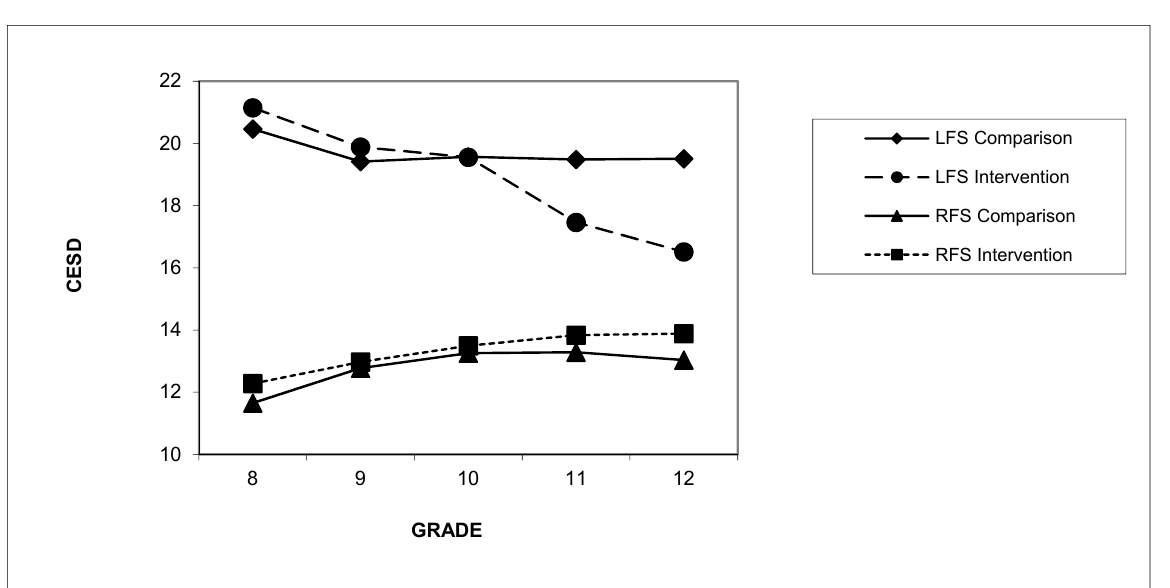
Figure 2. Estimated means for depression scores from Grades 8 to 12 by family support status and